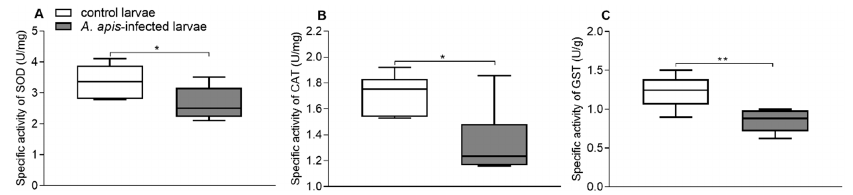
Figure 1. Comparative analysis of specific activities of SOD (superoxide dismutase, ( A )), CAT (catalase, ( B )), and GST (glutathione S-transferase, ( C )) between A. apis -infected larvae and controls. The error bar indicates SD; Asterisks represent significant differences (Student’s t test, * p < 0.05; ** p < 0.01).